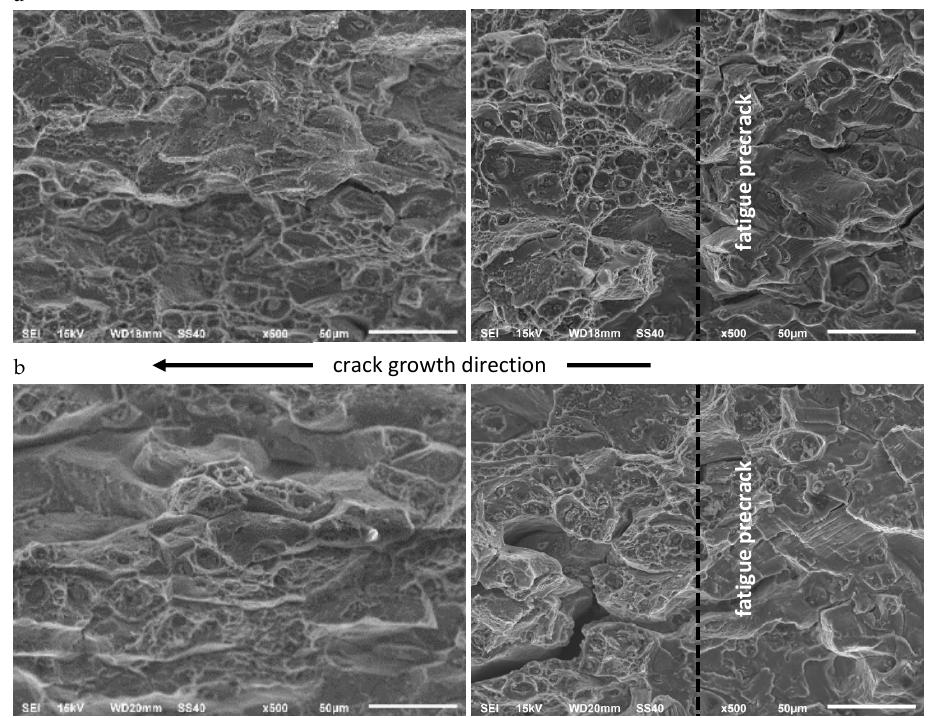
Figure 12. A comparison of AA2519 layer fractures relief in CT specimens made of Al–Ti laminate at 293 K ( a ) and at 77 K ( b ).